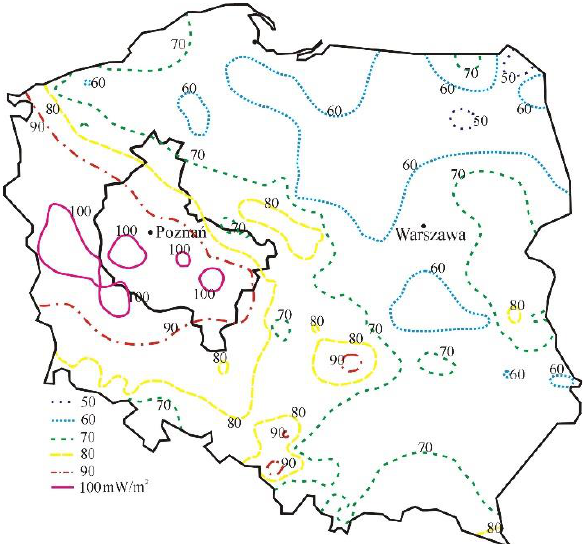
Figure 13. The map of terrestrial heat flow density for the Greater Poland Voivodeship in compari-